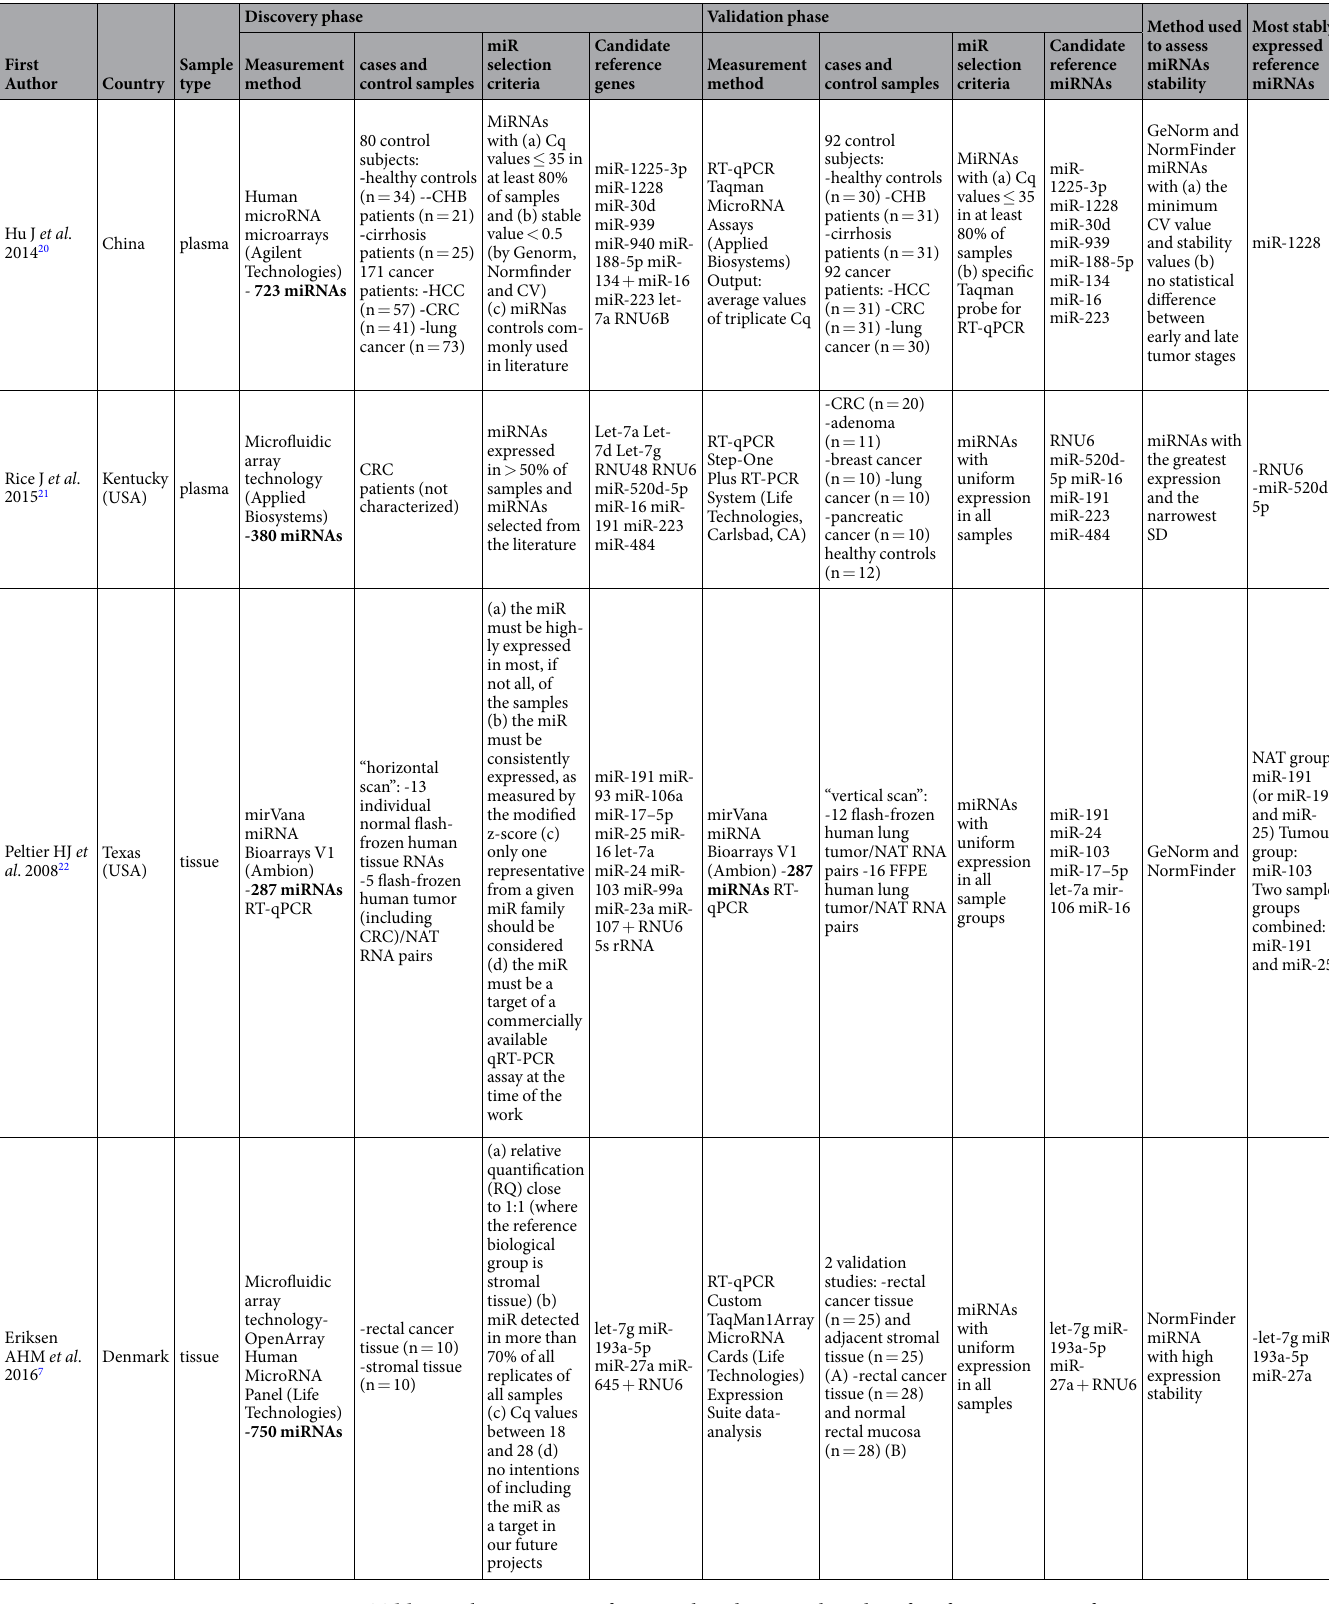
Table 1. Characteristics of retrieved studies aimed to identify reference miRNA for CRC experiments through high-throughput screening and subsequent qPCR validation. CHB, chronic hepatitis B; CV, coefficient of variability; FFPE, fixed paraffin-embedded; HCC, hepatocellular cancer; mCRC, metastatic colorectal cancer; NAT, normal adjacent tissue; NPC, nasopharyngeal; RT-qPCR, real-time